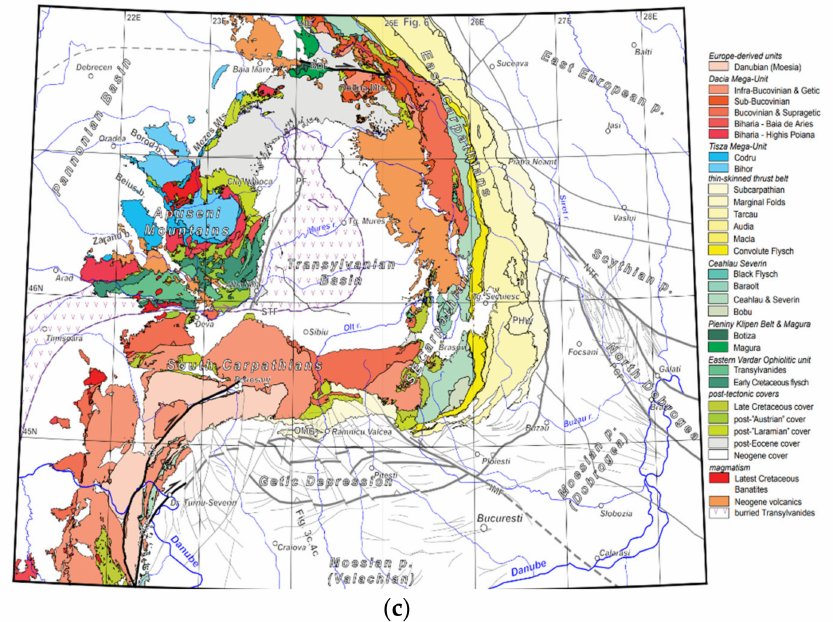
Figure 1. The area of analysis: ( a ) Romania and parts of the neighboring countries; ( b ) PSInSAR coverage of the studied area; ( c ) tectonic map of Romania (modified from